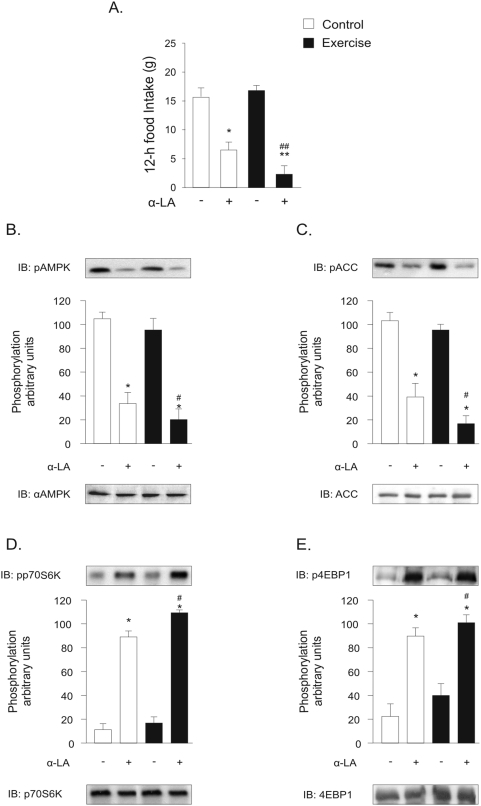
α-LA effects on 12-h cumulative food intake and AMPK/mTOR signaling, in the hypothalami of control and exercised rats.(a) α-LA (3 µg) was administered in control and exercised rats. Animals were immediately exposed to food for a 12-hour period (n = 8–10 animals per group). (b, c, d, e) Representative Western blots of four independent experiments showing hypothalamic lysates from Wistar rats. Phospho-AMPKthr172, threonine-phosphorylated AMPK and total AMPK (b); phospho-ACCser79, serine phosphorylated ACC and total ACC (c); phospho-p70S6Kinasethr389, threonine phosphorylated p70S6Kinase and total p70S6K (d); phospho-4EBP1thr70, threonine phosphorylated 4EBP1 and total 4EBP1 (e). Data are the means±SEM. * p<0.05, vs. control group; # p<0.05, vs. exercised non-stimulated group.